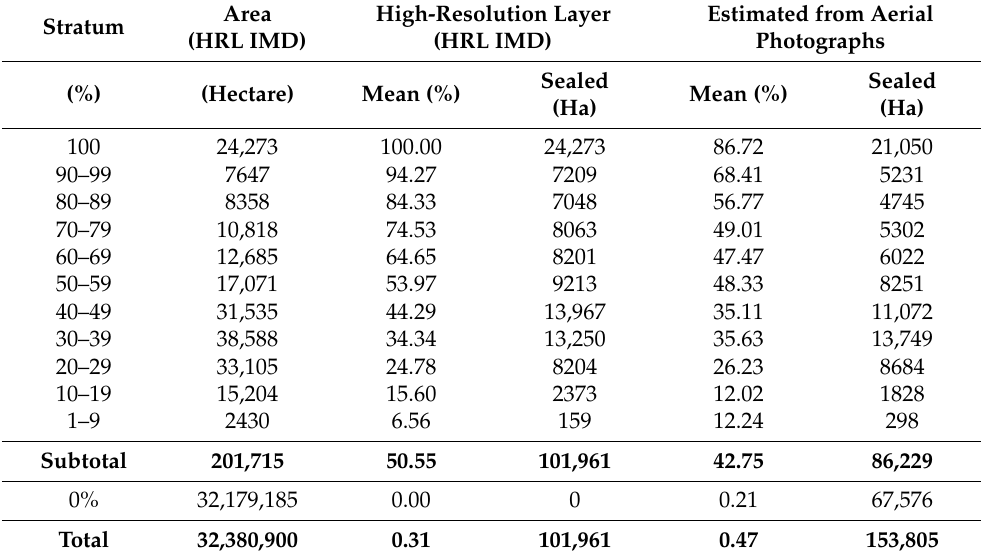
Table 1. Imperviousness in Norway as reported by HRL IMD and as estimated by sampling. The total land area (32,380,900 hectares) is divided into strata according to the degree of imperviousness reported by HRL IMD. Mean imperviousness and the corresponding sealed area were calculated for each stratum, as well as for a subtotal of all strata with reported imperviousness (according to HRL IMD) and for the whole